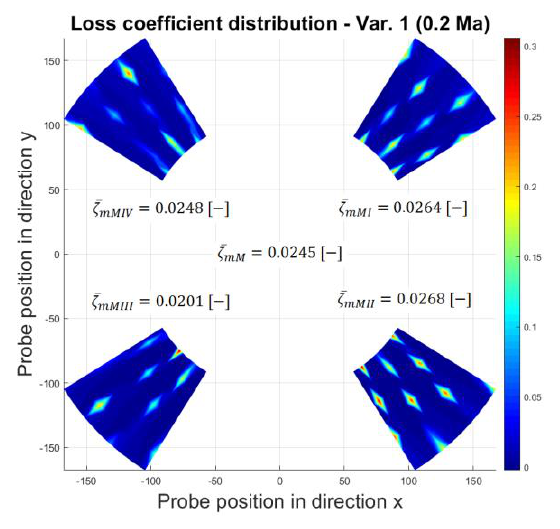
Fig. 10. Loss coefficient distribution.